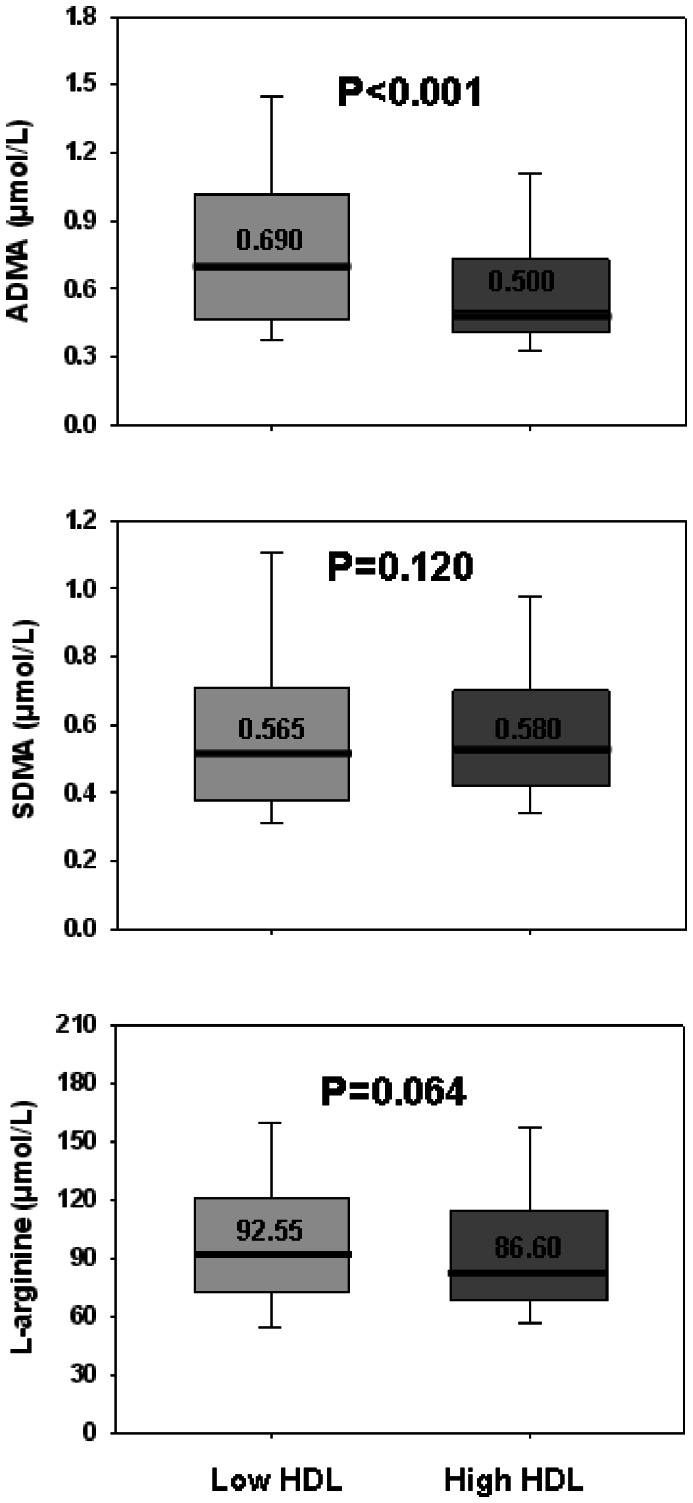
L-arginine and dimethylarginines concentrations in patients according to their HDL levels.The horizontal line is the median, box is the IQR (interquartile range) and whiskers are the 95% range. P values are from Mann-Whitney tests.